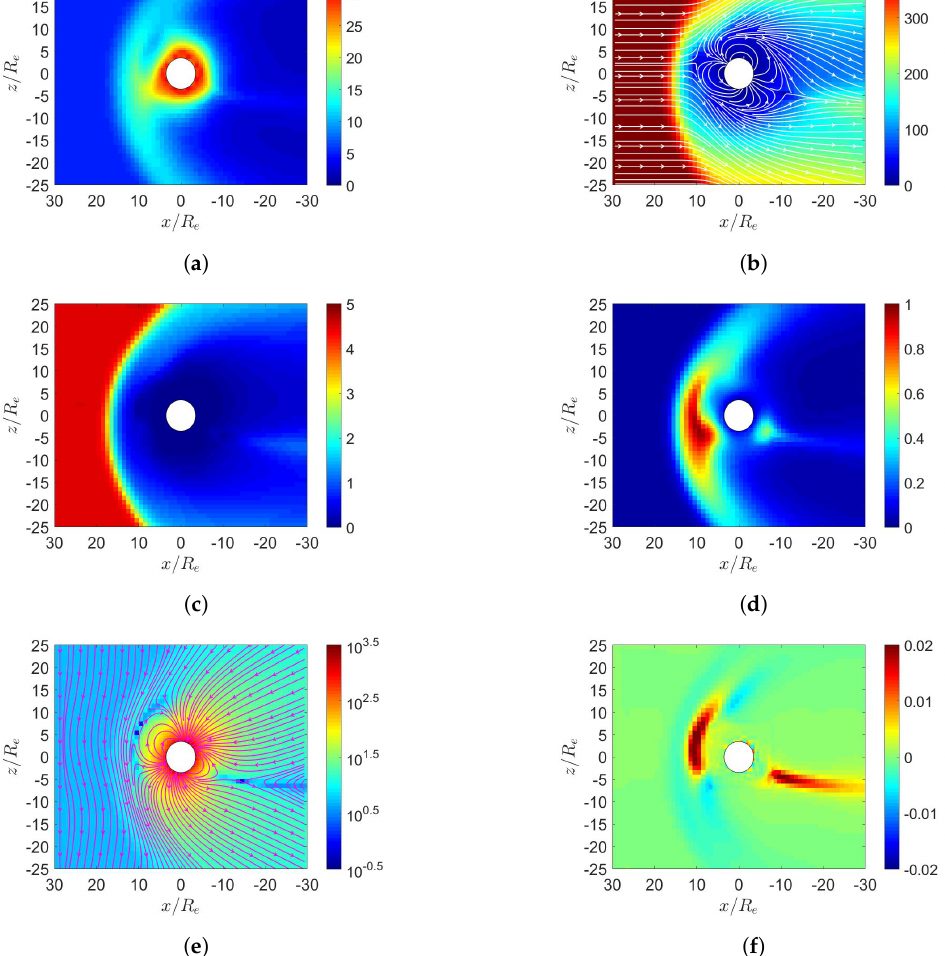
Figure 5. Distributions around Earth of ( a ) n (cm − 3 ), ( b ) ¯ u xz (km/s), ( c ) magnetosonic Mach number, ( d ) P (nPa), ( e ) ¯ B xz (nT), ( f ) J y ( µ A/m 2 ); southward IMF in December, t = 27